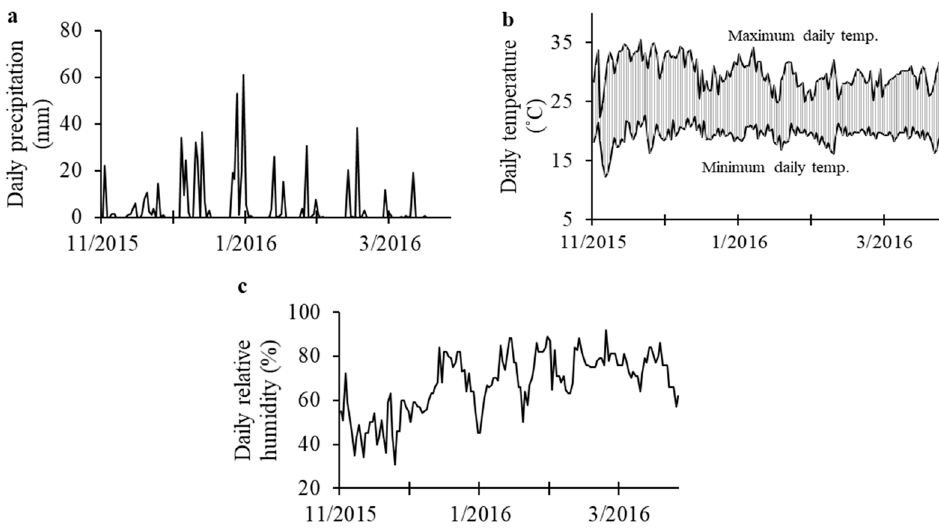
Figure 1. Temporal variations in daily ( a ) precipitation, ( b ) temperature, and ( c ) relative humidity during 2015/2016 cropping season.